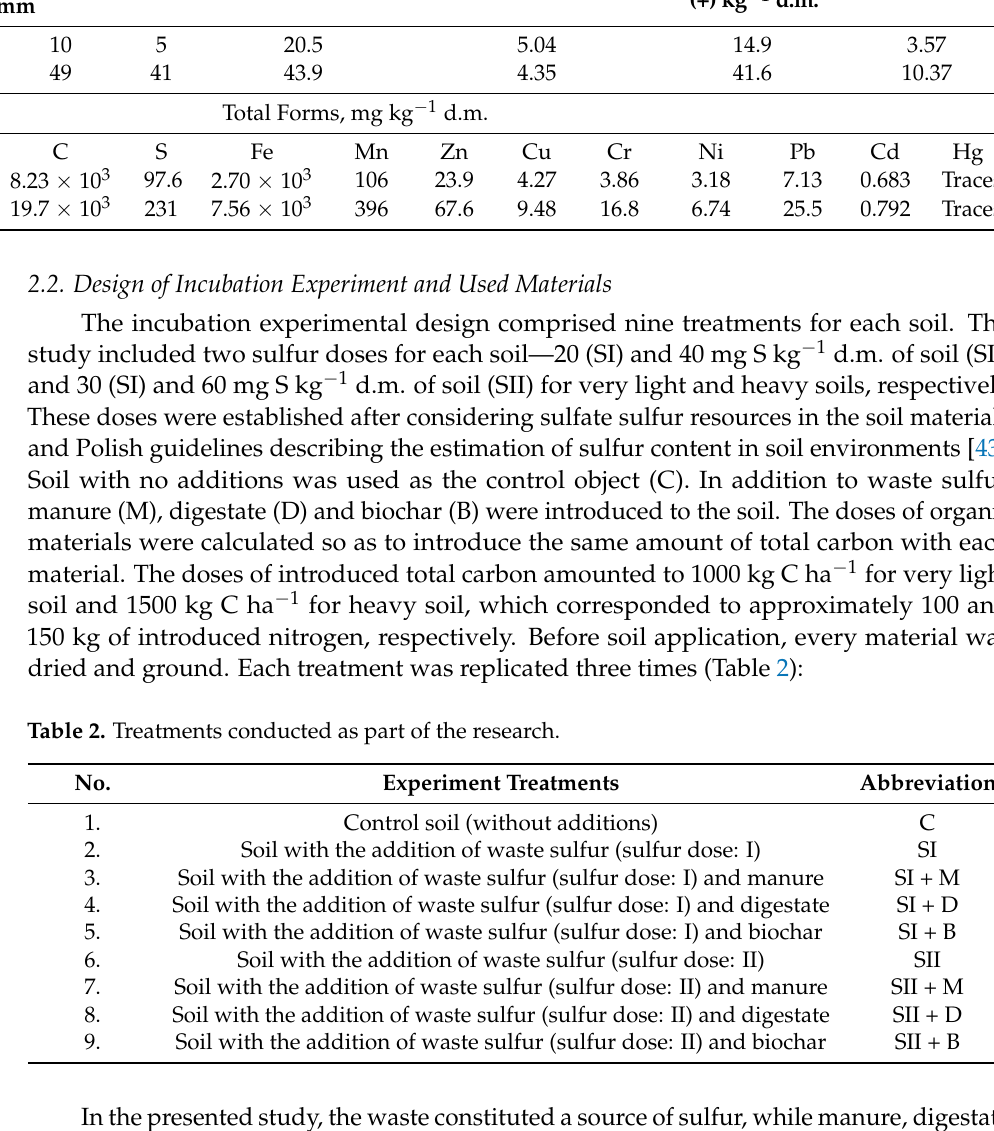
Table 1. Selected properties of soil material before establishing the experiment. Soil Texture, % Soil